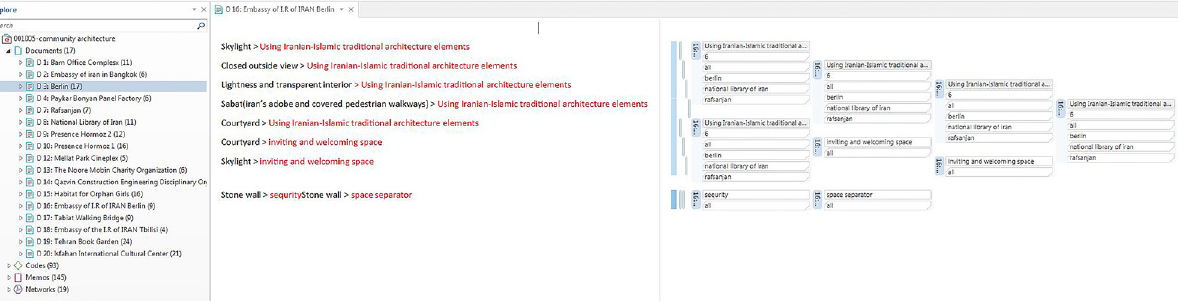
Figure 12. A case of qualitative analysis with ATLAS.ti for a sample project (source: authors) Table 6. Key codes related to SCI (source: Chavis et al., 1986; Kamelnia, 2008)